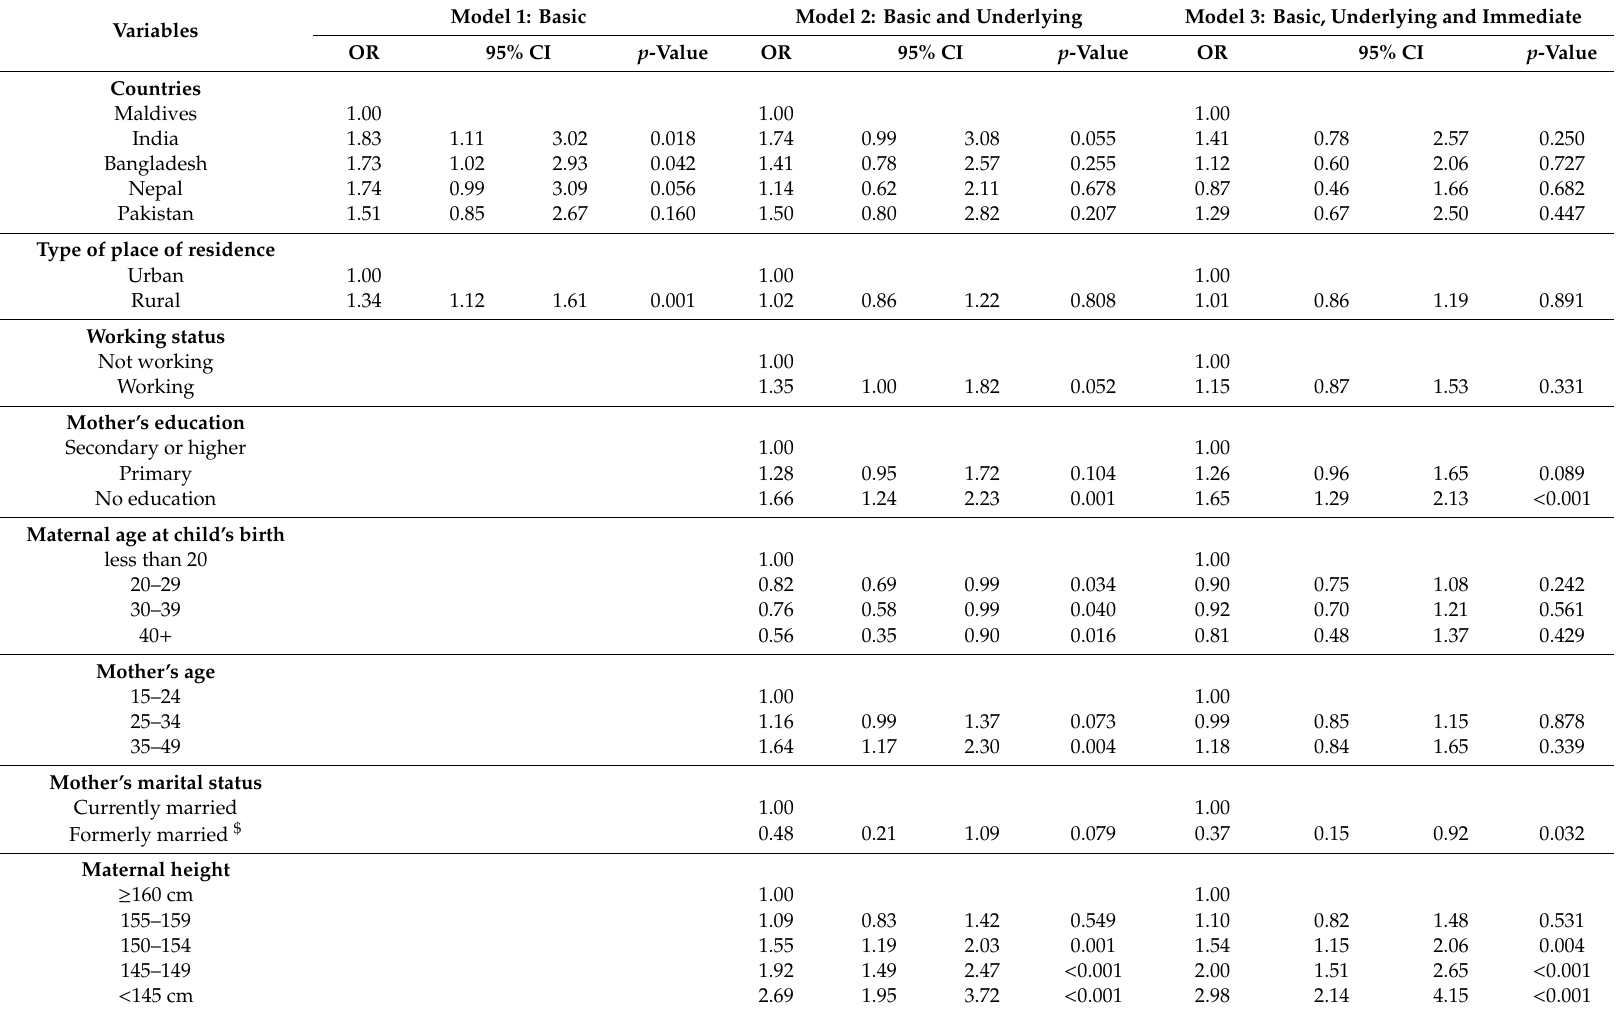
Table 1. Factors associated with stunting in children aged 0–23